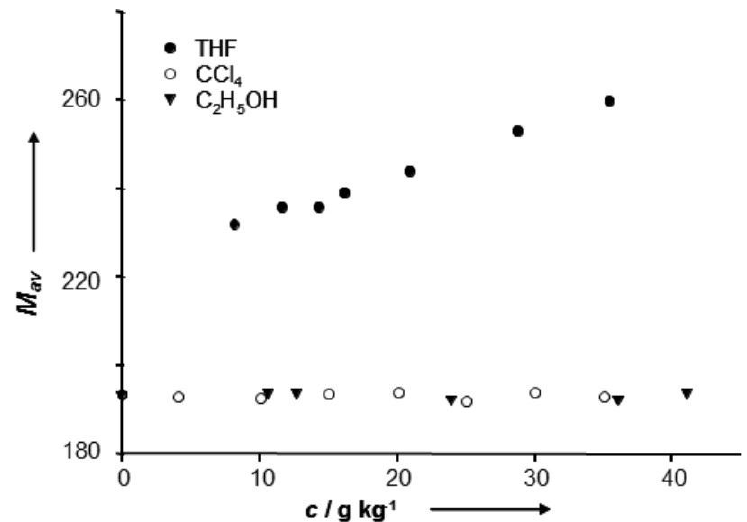
Figure 17. Dependence of average molecular weight (M av ) on concentration. Reprinted with